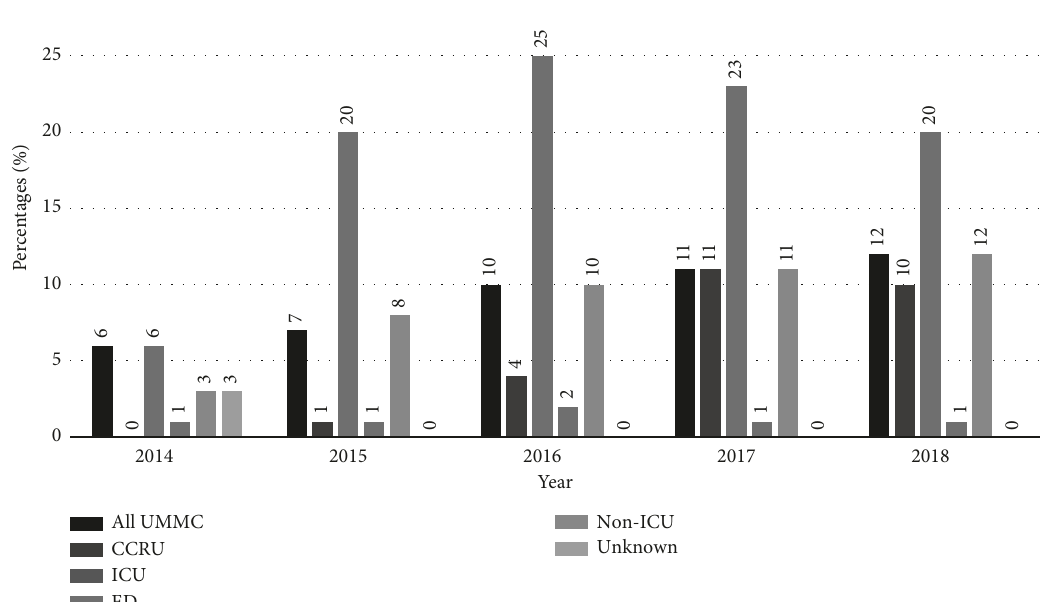
Figure 5: Lost admissions to UMMC units over the 5-year study period. Abbreviations: CCRU, critical care resuscitation unit; ED, emergency department; ICU, intensive care unit; UMMC, University of Maryland Medical